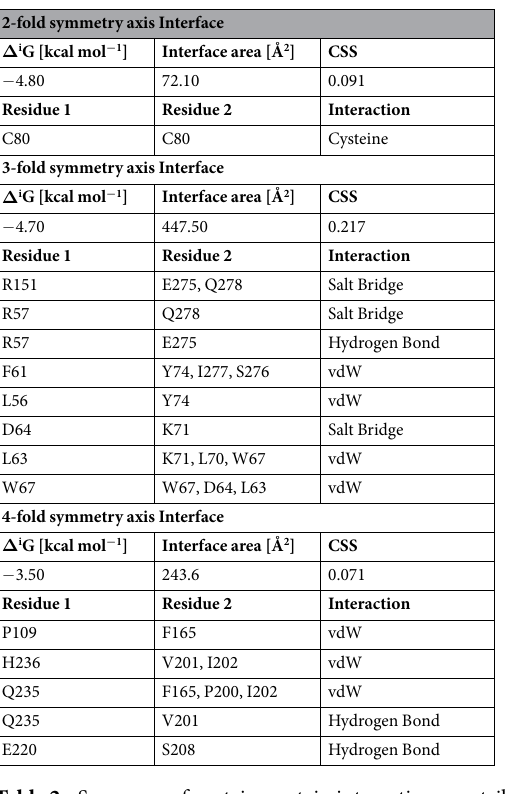
Table 2. Summary of protein-protein interactions contributing to the stability of α -TTP S . The PDBePISA 84 web-based tool was used to evaluate protein-protein interactions. Δ i G indicates the solvation free energy gain upon formation of the interface, in kcal/M. The value is calculated as difference in total solvation energies of isolated and interfacing structures. Negative Δ i G corresponds to hydrophobic interfaces, or positive protein affinity. This value does not include the effect of satisfied hydrogen bonds and salt bridges across the interface. Interface area in Å 2 , calculated as difference in total accessible surface areas of isolated and interfacing structures divided by two. CSS stands for the Complexation Significance Score, which indicates how significant for assembly formation the interface is. The score is defined as a maximal fraction of the total free energy of binding that belongs to the interface in stable assemblies.